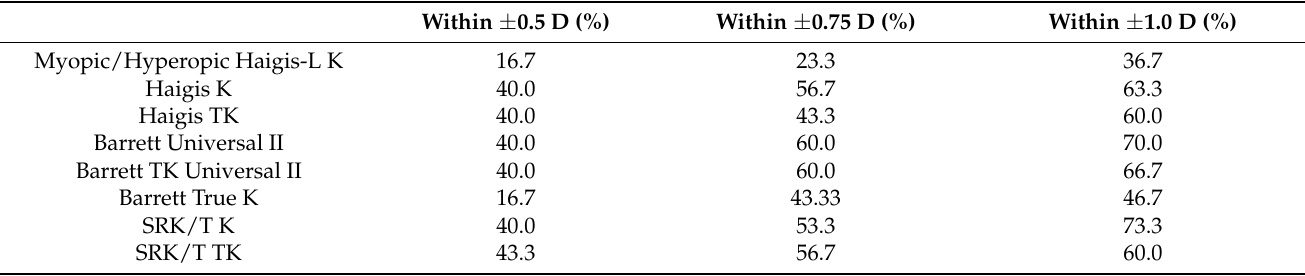
Table 3. The proportions of eyes within ± 0.25 D, ± 0.50 D, and ± 1.00 D of predicted postoperative spherical equivalent refraction at 2 months after